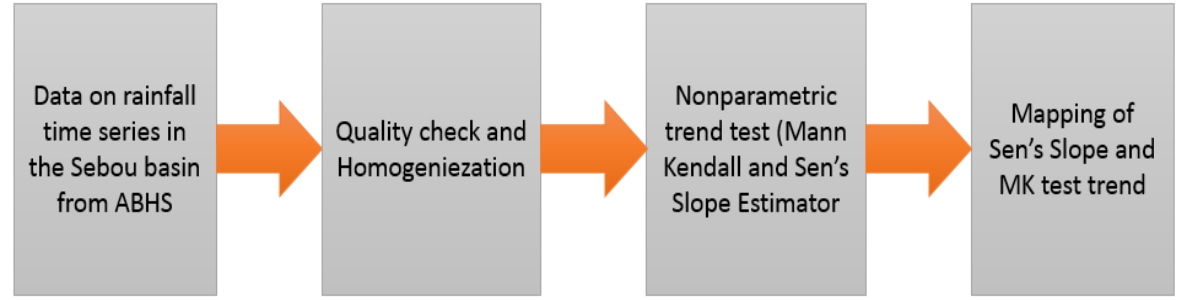
Figure 2. Methodology used in this paper.